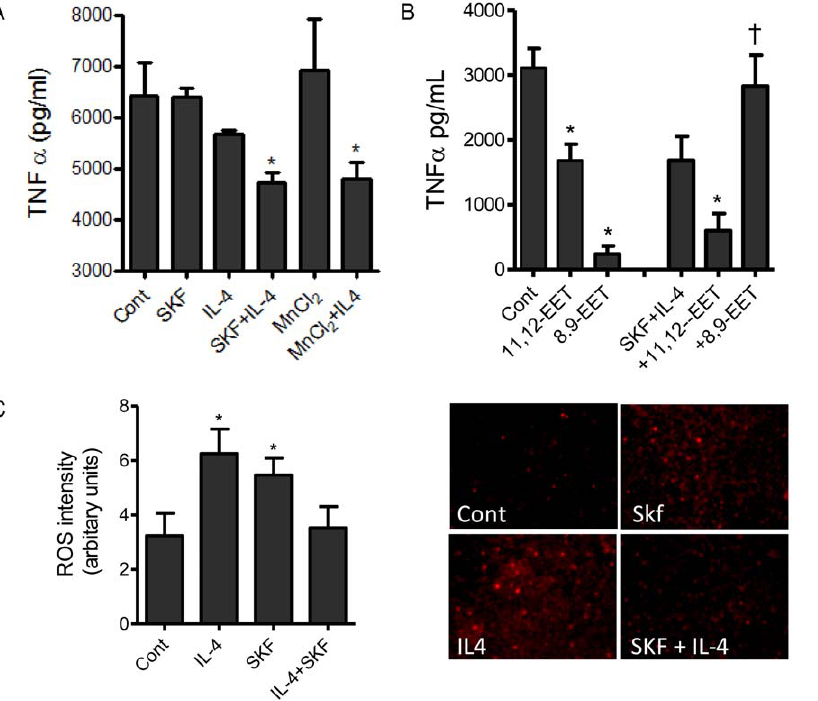
Figure 5. Epoxygenase inhibition in alternatively activated monocytes inhibits TNF a release: a role for superoxide generation. (A) shows the acute release of TNF a from THP-1 cells over 7 h with vehicle treatment (Cont), or treated with SKF525A (10 m M), IL-4 (20 ng/ml), the superoxide dismutase, MnCl 2 (10 m M) or a combination of IL-4 and SKF525A or IL-4 and MnCL 2 . (B) shows inhibition of basal TNF a release from THP-1 cells treated with 11,12-EET or 8,9-EET (1 m M) in the presence of absence of SKF (10 m M) with IL-4 (20 ng/ml). Data represents mean 6 SEM of n=3 experiments. * indicates EET difference from control, while { indicates EET difference from IL-4 with SKF525A. (C) shows the production of superoxide (left figure; arbitrary units), or representative florescent micrographs (right panels), from THP-1 cells treated for 7 h with vehicle treatment (Cont), SKF525A (10 m M), IL-4 (20 ng/ml), or a combination of IL-4 and SKF525A. The superoxide sensor, dihydroethidium (10 m M) was added for the last 30 min and staining intensity analyzed using a Nikon TE2000 inverted florescent microscope connected to a SPOT-RT digital camera. Data represents mean 6 SEM of n=3 2 4 experiments. *denotes p , 0.05, by one-way ANOVA and Bonferroni’s post-test compared to control cells.